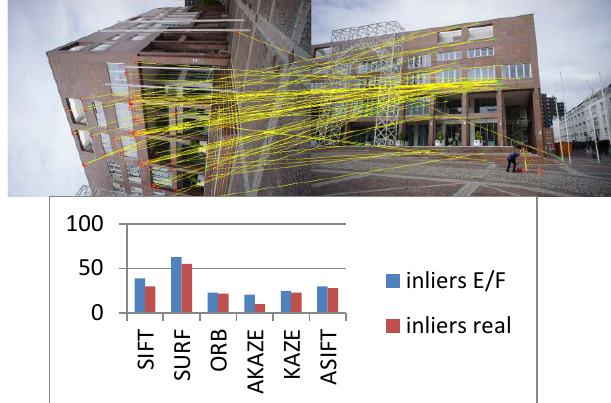
Figure 5: pair-2 results. Upper: SURF matches, lower: for each number of matches after E-/and F-based filtering (blue) and real inliers (red) The result (see Figure 5) show that all matchers yield much fewer valid tie point connections compared to pair 1. Again 3 A visualization of matches from all six approaches for all